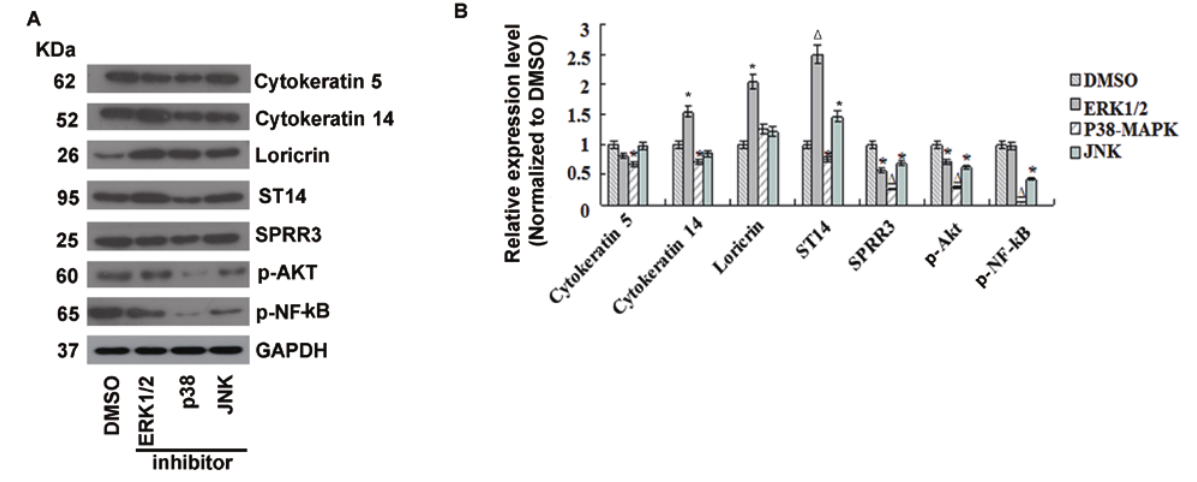
Figure 2: Inhibition of the MAPK pathway affected expression of differentiation-related proteins. A. Western blotting results of differentia- tion-related proteins. NHEKs were treated with 20 µM SB203580, 100 µM PD98059 or 50 µM SP600125, respectively. B. Semi-quantitative analysis of differentiation-related proteins, compared with the control (DMSO), n = 3, *P < 0.05, ΔP <